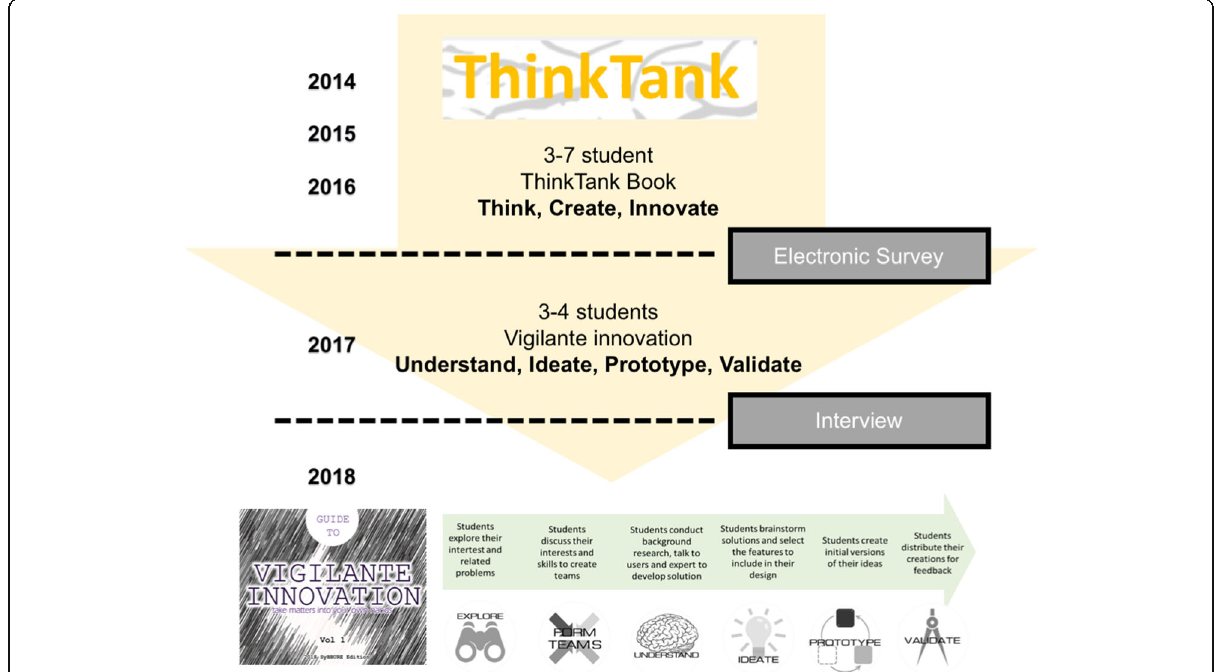
Fig. 3 Evolution of Vigilante Innovation. The program was first piloted in 2014 with an early version called ThinkTank. This evolved, based on student feedback, practical implementation, and experience, to VIX in 2017. The current framework of VIX, including the phases and phase descriptions, is shown at the bottom. The VIX guidebook with resources and activities for implementing a design project can be found online at